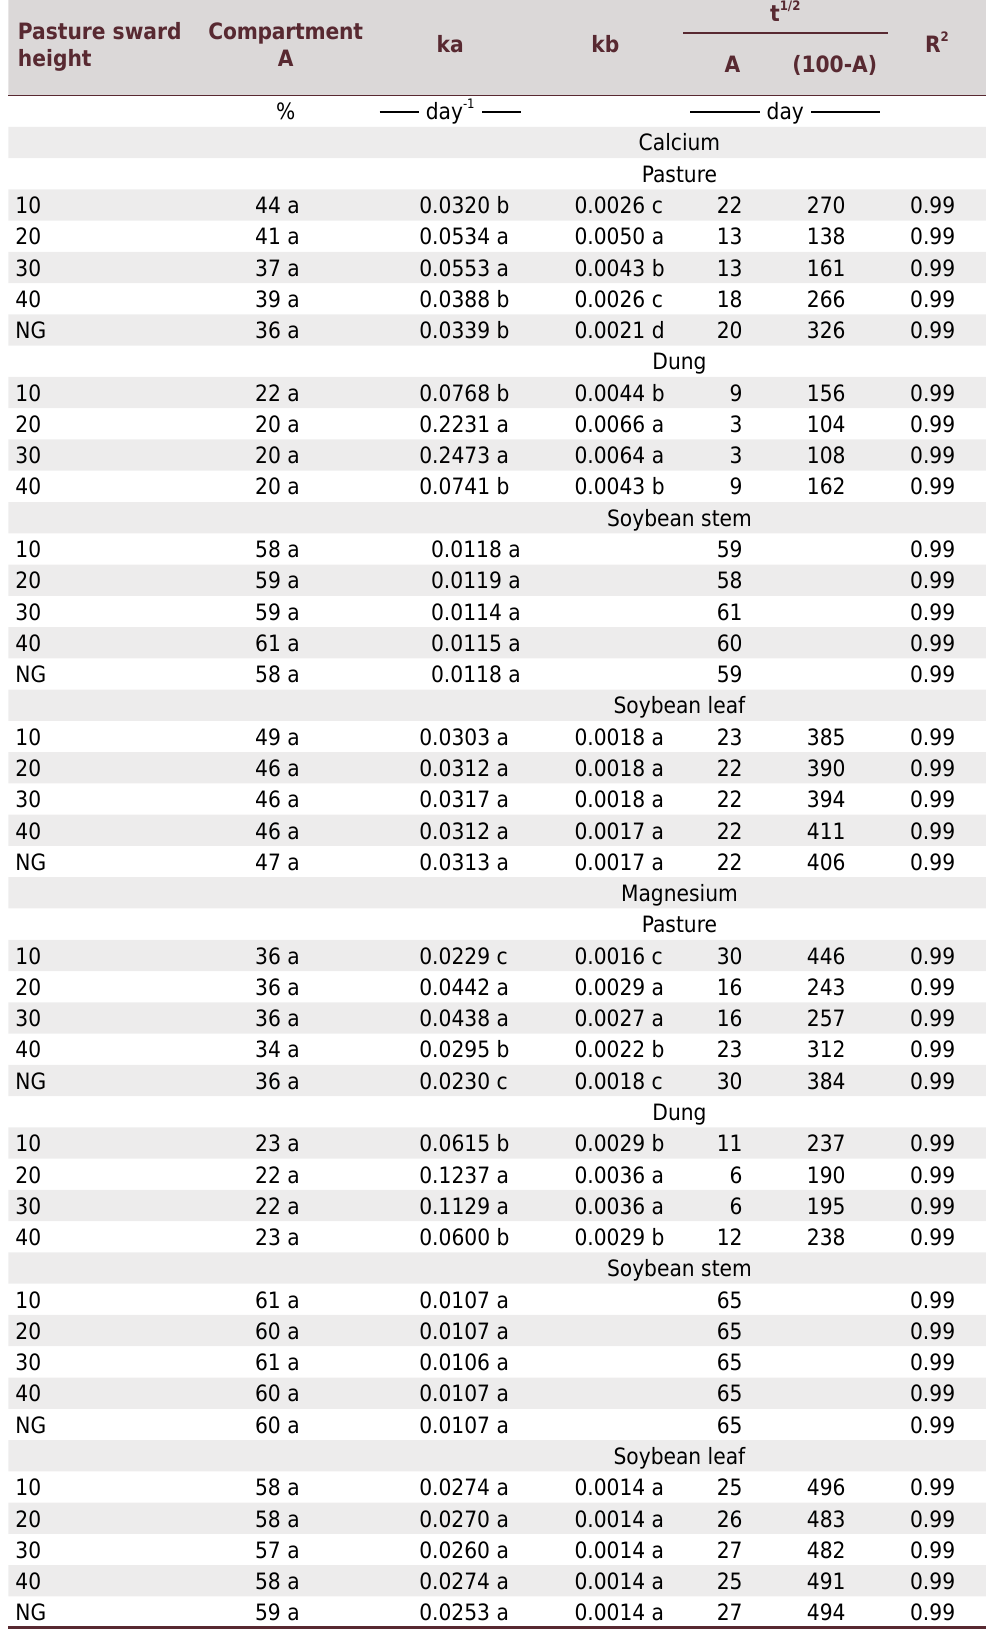
Table 3. Parameters of single and double exponential models fitted to calcium and magnesium residue release rates, calculated half-life values (t 1/2 ), and correlation coefficient (R 2 ) in an integrated soybean-beef cattle system under no-till with varying grazing intensities (i.e., sward height managed by grazing) (São Miguel das Missões, RS, Brazil) Pasture